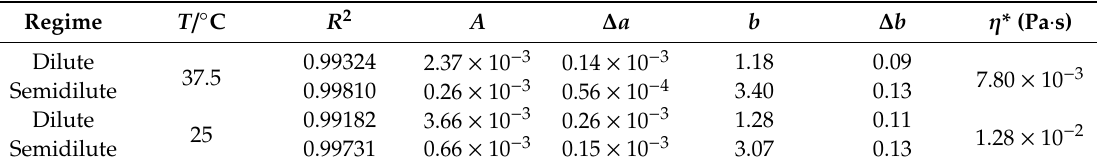
Table 3. Values of coe ffi cients a and b of equation η = a · c b related to the fitting of flow step data. Regime T / ◦